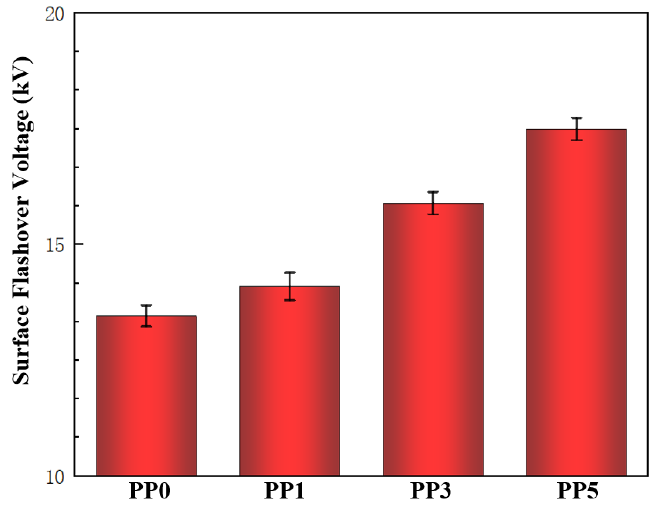
Figure 9. The flashover voltage along the surface of films.